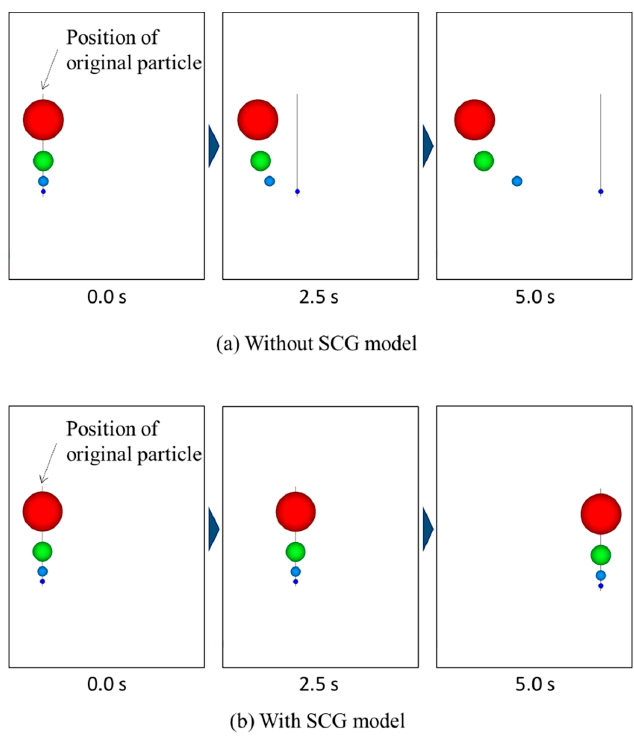
Figure 2. Comparison of particle behaviors on uniform flow field represented by DEM with and without the SCG model.